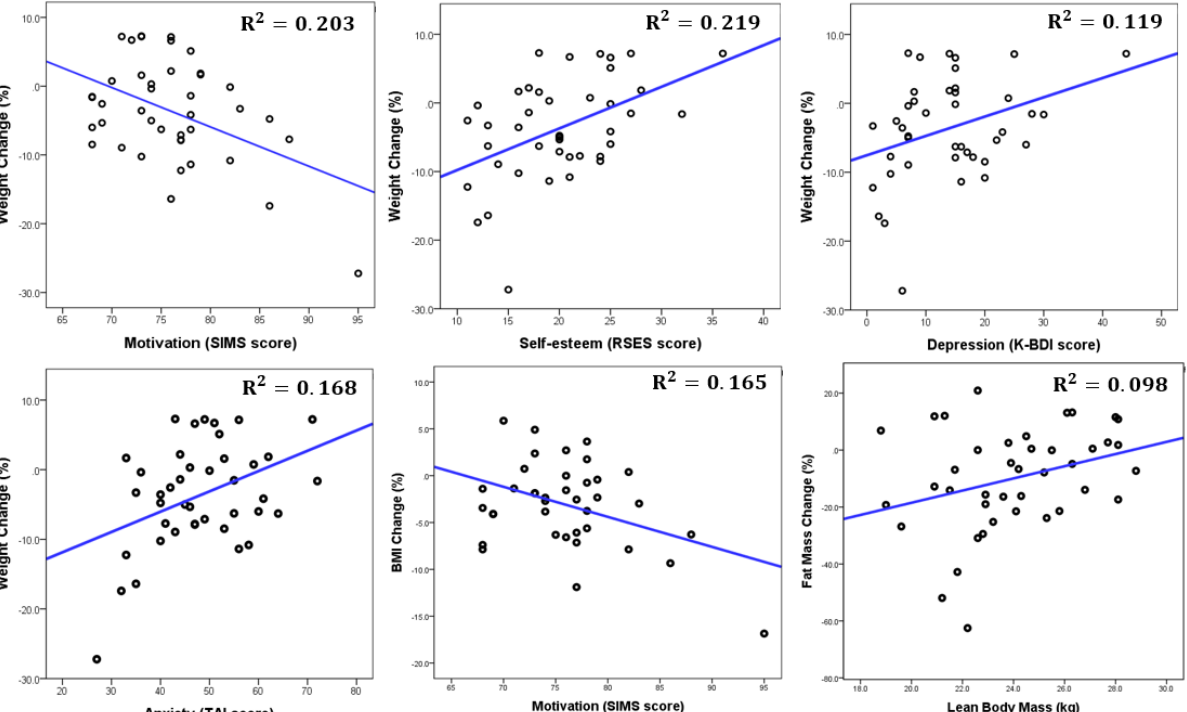
Figure 8. The correlation between weight change at the long-term follow-up period (24 weeks) and the level of motivation, self-esteem, depression, and anxiety at baseline. Also shown are the correlation between BMI change at the long-term follow-up and the level of motivation at baseline, and the correlation between fat mass change at the long-term follow-up and lean body mass at baseline. K-BDI: Korean version of the Beck Depression Inventory; RSES: Rosenberg Self-Esteem Scale; SIMS: Situational Motivation Scale; TAI: Trait Anxiety